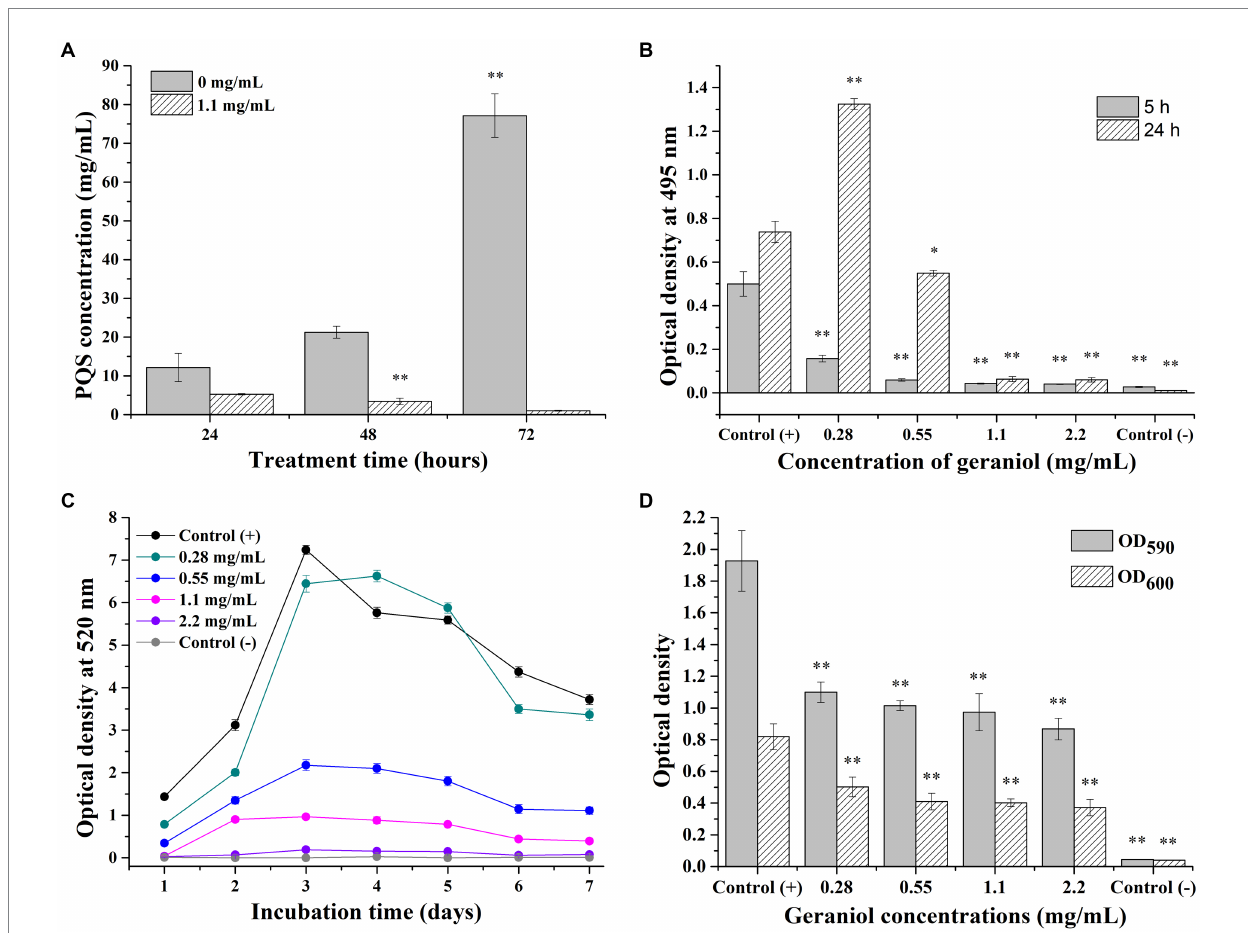
FIGURE 5 Maps presenting the effect of geraniol on Pseudomonas aeruginosa PAO1 virulence factors. (A) Histogram of Pseudomonas quinolone signal production. (B) Histogram of elastase LasB production. (C) Curves of pyocyanin production. (D) Histogram of biofilm and planktonic cell yield. OD 600 and OD 590 mean relative planktonic cell concentration and biofilm yield, respectively. Independent Student’s t -tests were performed to compare the control and geraniol treatment groups. * p < 0.05; ** p <